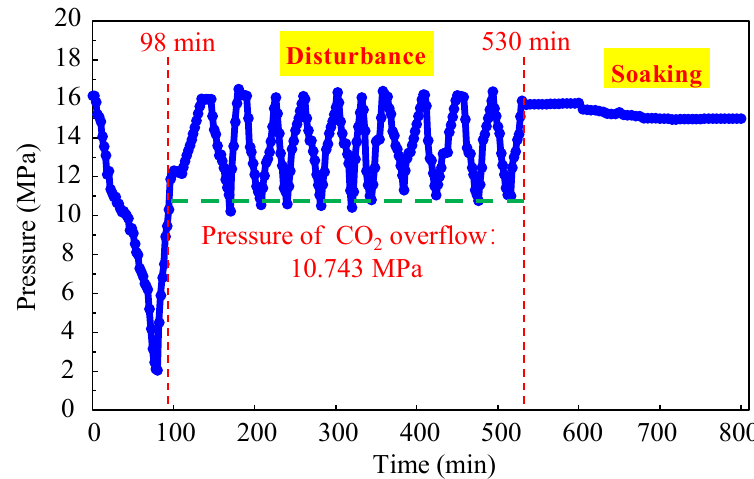
Figure 5. Pressure dynamic curve during the soaking of case two.